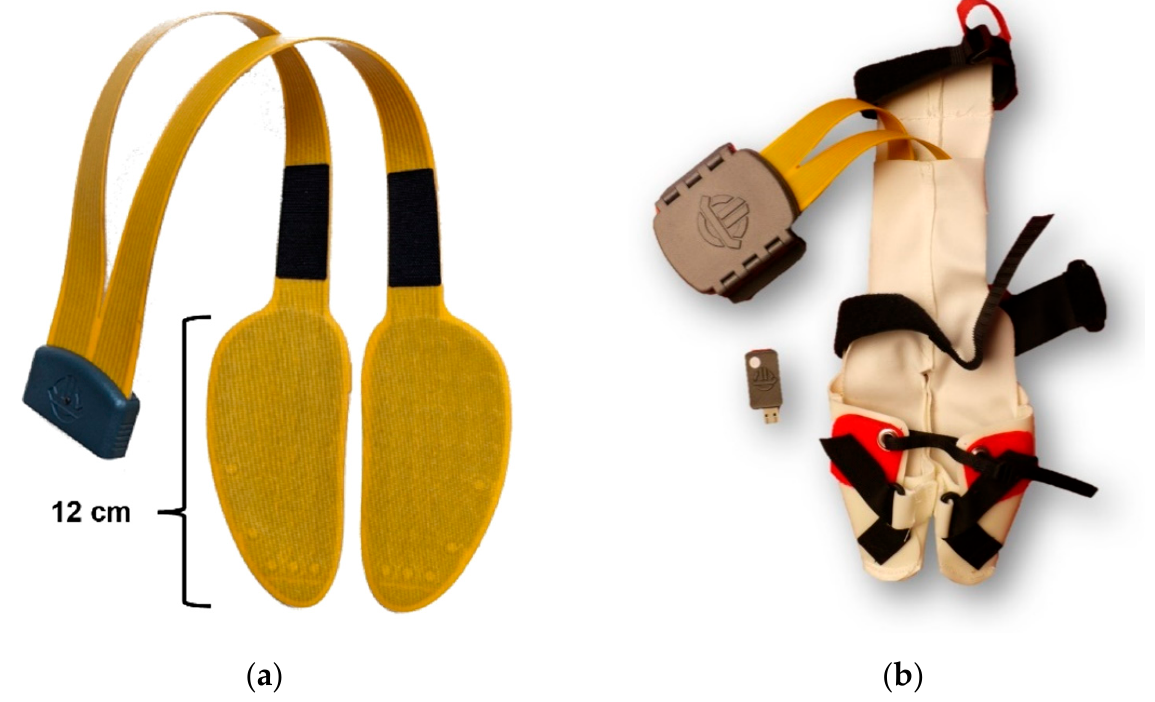
Figure 1. Sensor systems used for gait analysis in ten dairy cows: ( a ) paired claw-shaped pressure sensor soles; ( b ) textile claw shoe for attachment of the sensors.